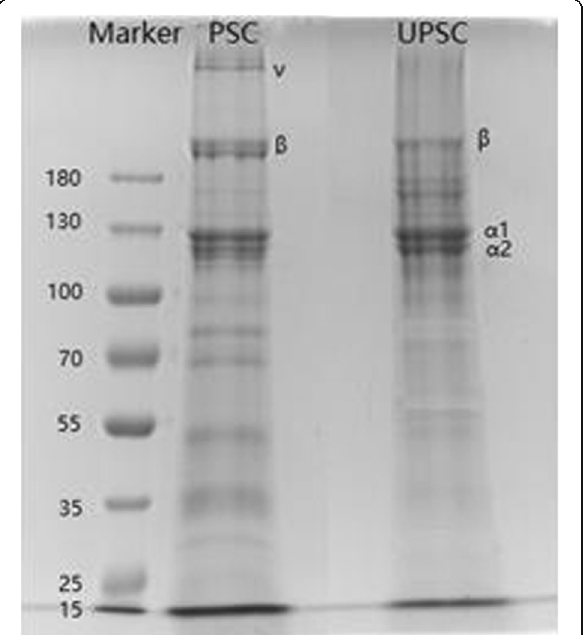
Fig. 3 Fourier transforms infrared spectra (FTIR) of PSC and UPSC from chicken